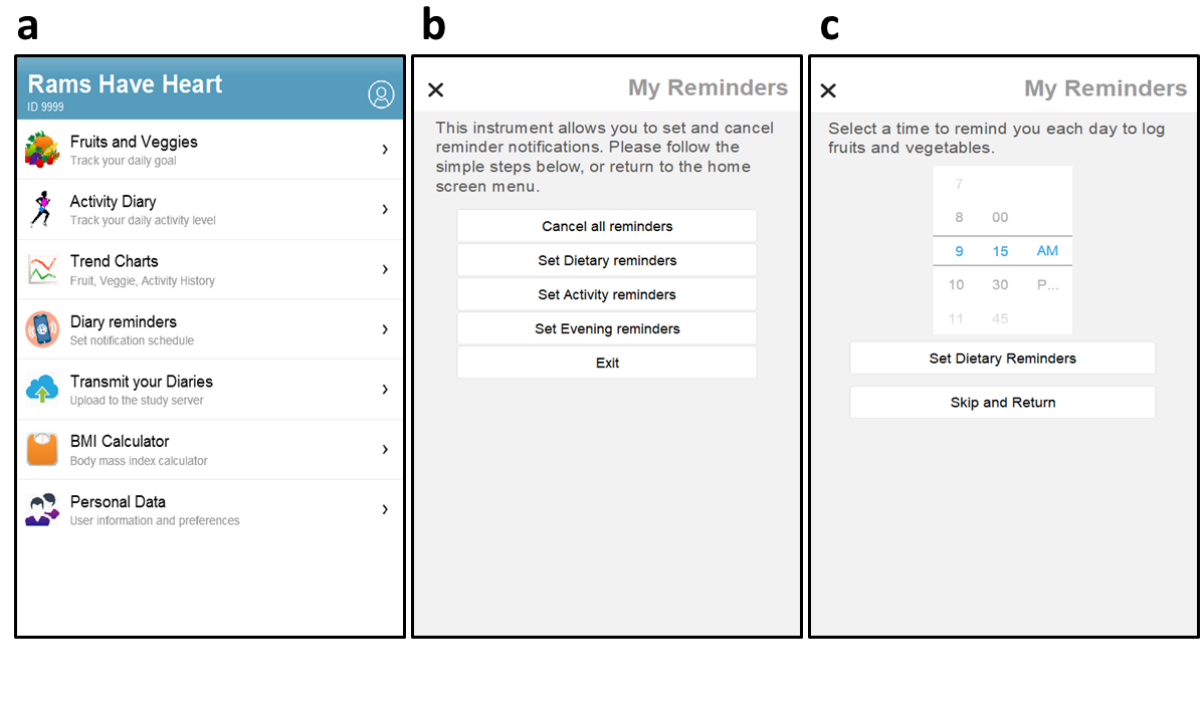
Figure 1. Home screen menu for the Rams Have Heart app (a) and screens for selecting (b) and setting (b) daily diary